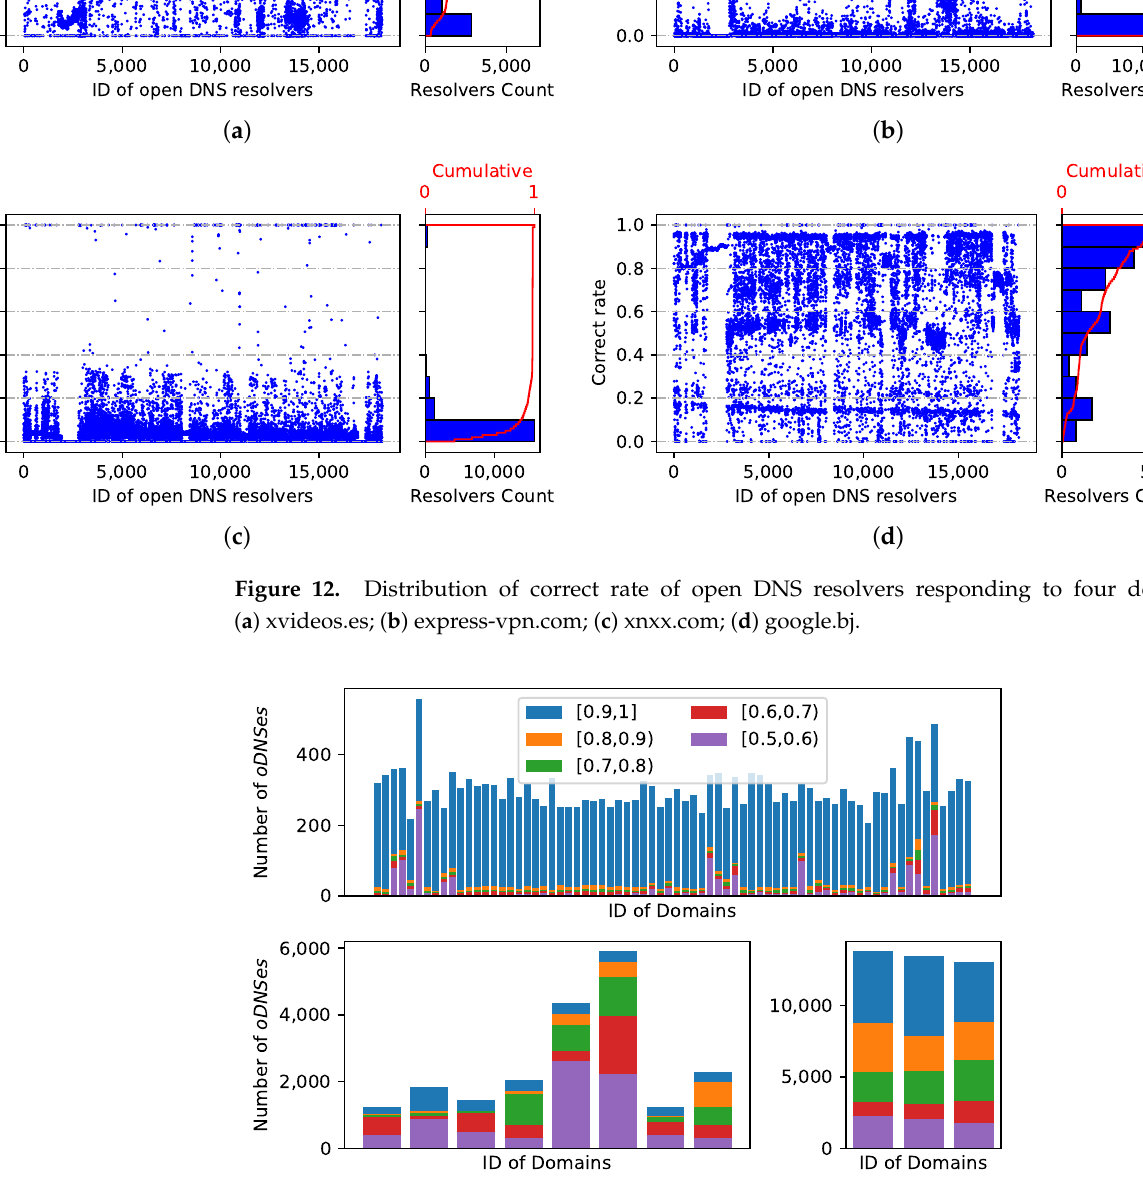
Figure 13. Distribution of the number of Open DNS resolvers responding to each blocked domain name (based on correct response